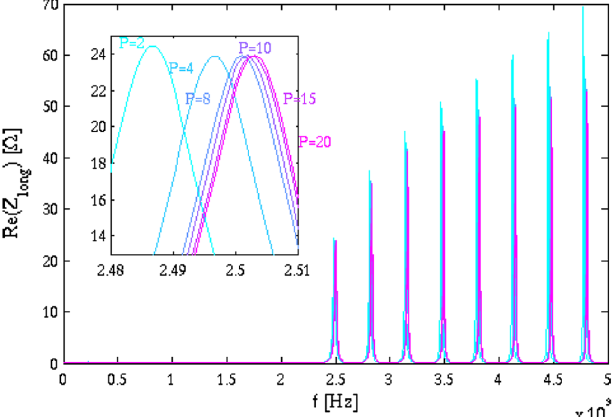
FIG. 3 (color online). Convergence of P modes in mode matching: narrow empty cavity case: L ¼ 2 mm, t ¼ 45 cm, b ¼ 5